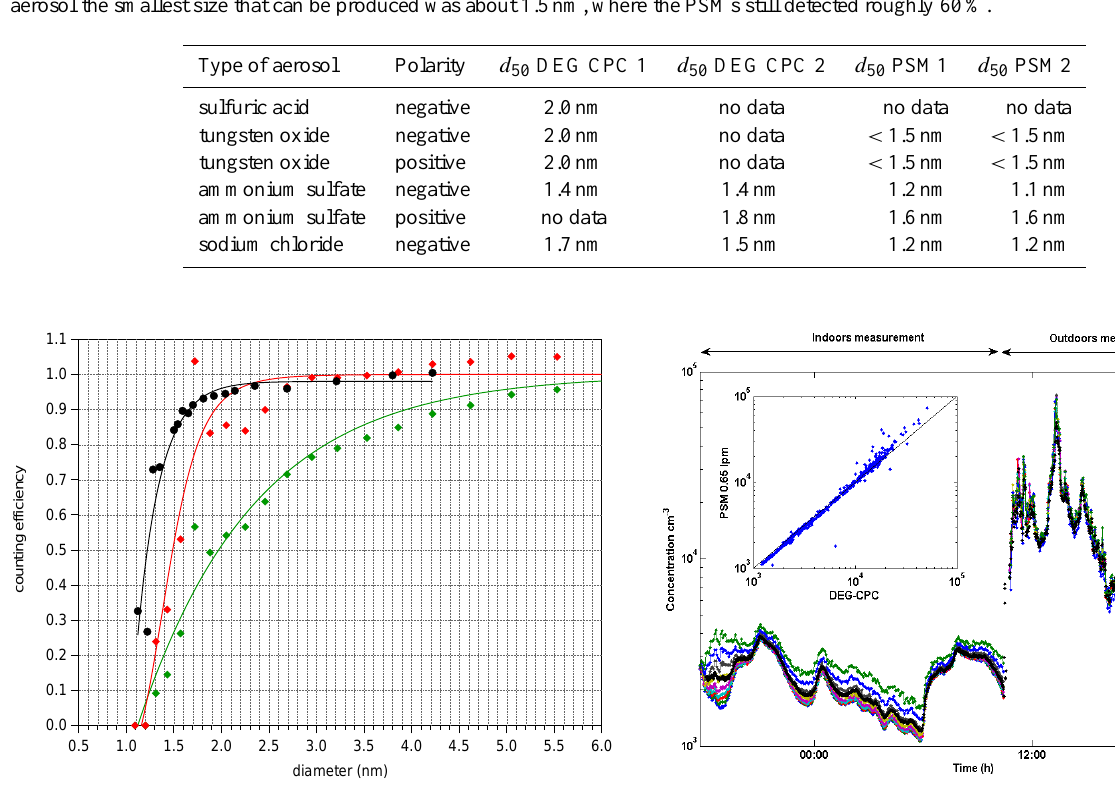
Fig. 10. Comparison of the scanning PSM and DEG CPC 1 measur- ing the total particle concentration indoors and outdoors. The differ- ent coloured lines for the scanning PSM show the different flow rate settings for the saturator flow. The scatter plot shows the correlation between the 0.55Lmin − 1 saturator flow setting for the scanning PSM and the DEG CPC 1. The slight spread of the data for higher concentrations might be due to coincidence in the DEG